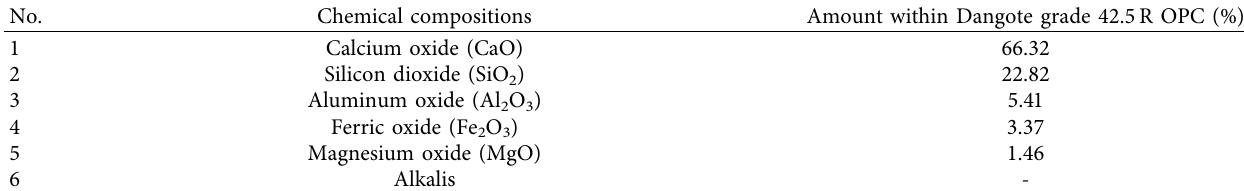
Table 1: The chemical makeup of Dangote grade 42.5R OPC cement.